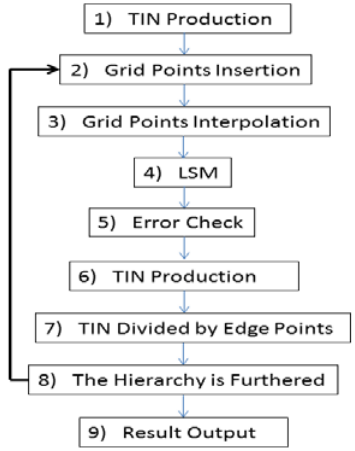
Figure 5. Flowchart of Edge Surface